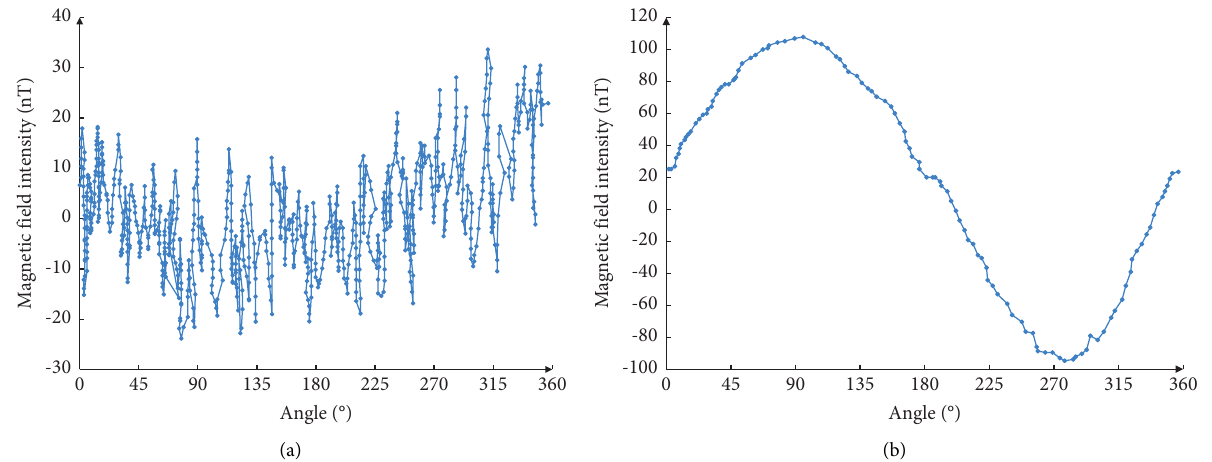
Figure 9: Simulation data when the distance from the probe to the casing is (a) d � 21 m and (b) d � 2m.